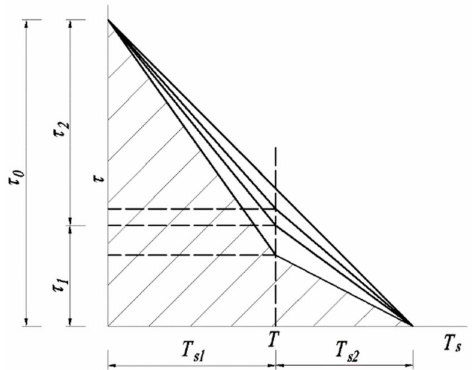
Figure 3. One-stage and two-stage closing laws of guide vanes [21].